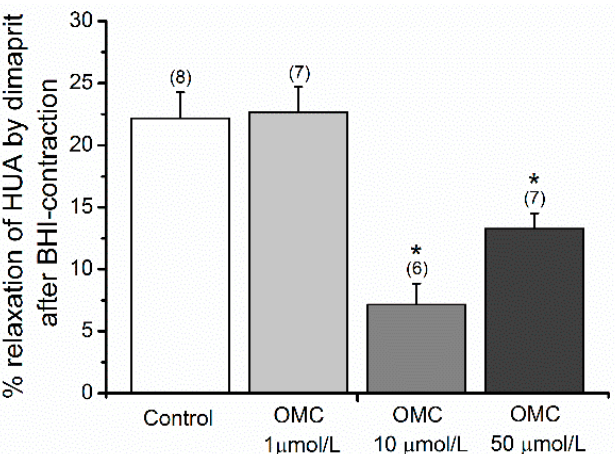
and 50 µ mol/L (13.265 ± 1.268%) OMC, when compared to HUA-rings from the control group (22.184 ± 2.080%).